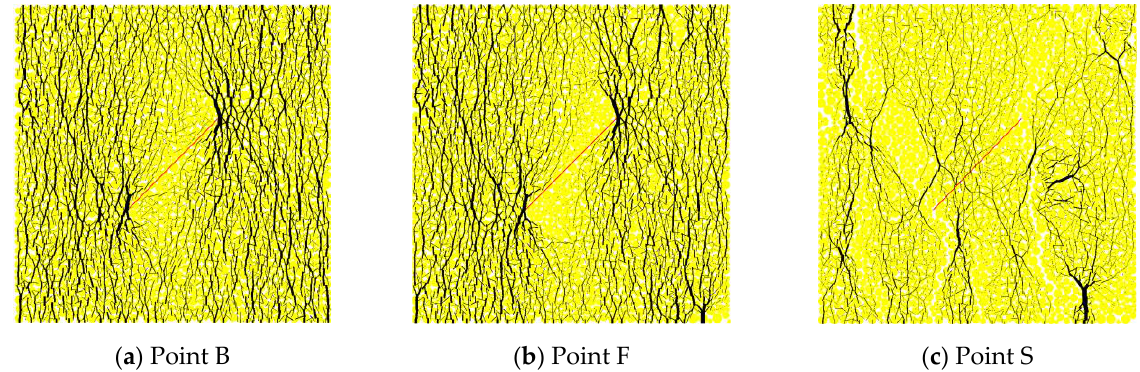
Figure 14. Evolution of force chain distribution with axial strain increases ( 𝛽 =45°).